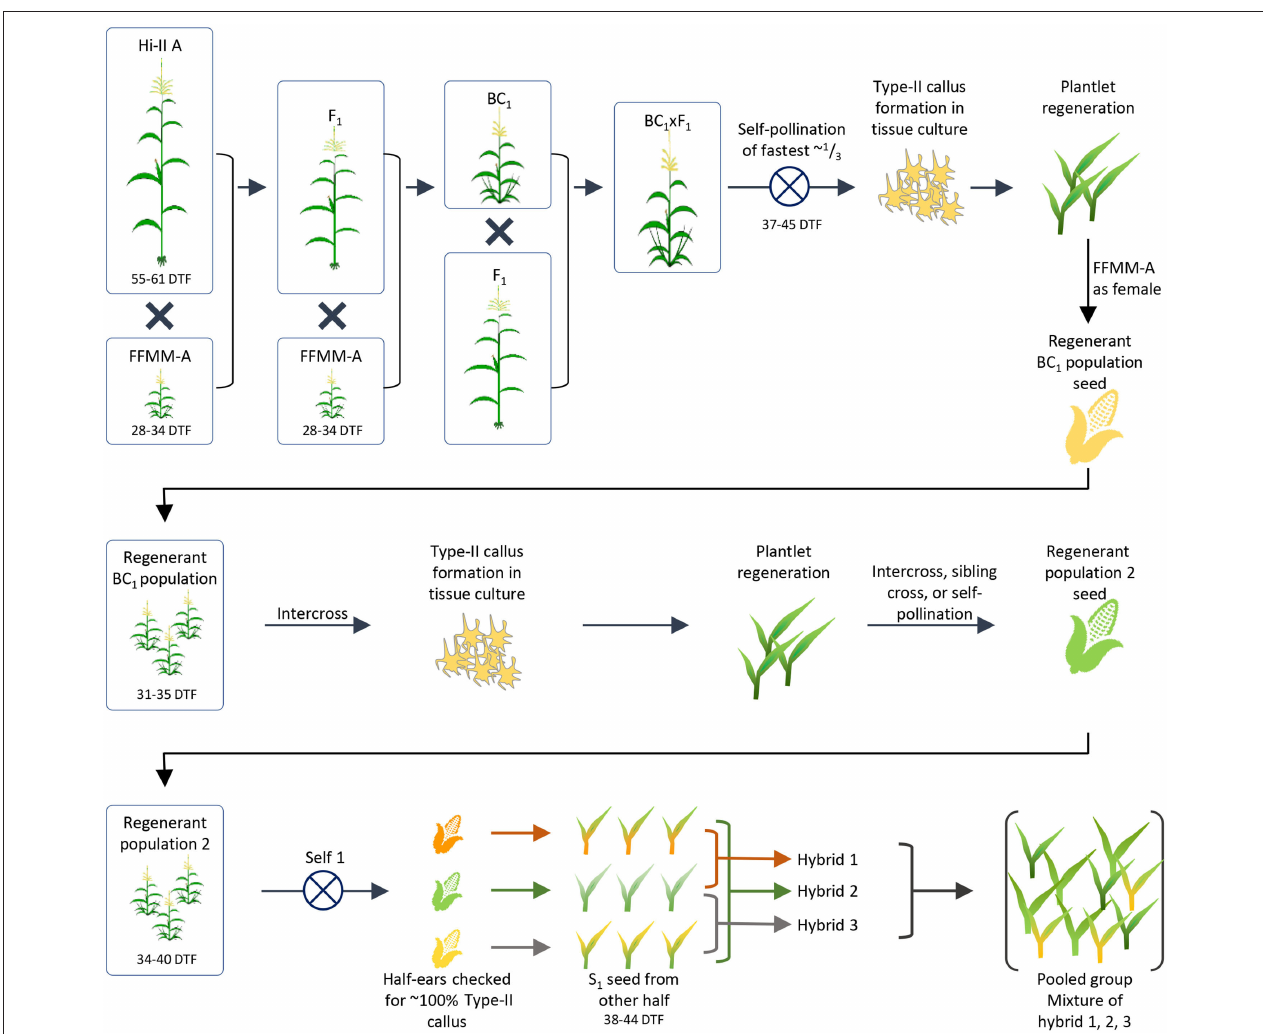
FIGURE 1 | Generation of initial FFMM-AT population. The breeding process used to create a population of plants with FFMM characteristics and the ability to form Type-II callus in tissue culture. From an initial F1 × BC1 crossing, callus was induced and regenerated plants were backcrossed as males to FFMM-A. The population was passed through tissue culture again to select for formation of Type-II callus, and regenerated plants formed a second population. Half-ears of selfed plants were checked for ∼ 100% Type-II callus responses and presumed fixation of the trait. Plants derived from the seed of the other half of ears resembled FFMM-A but took too long to flower so they were intercrossed to form a final population from which fast-flowering lines could be selected. DTF, days to flowering.